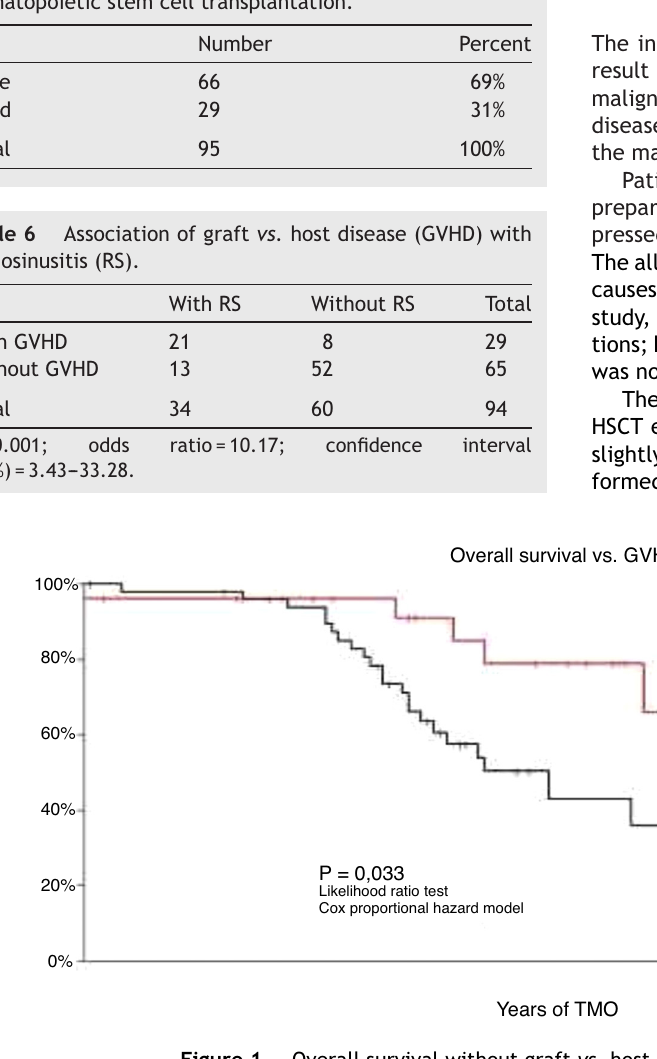
Overall survival without graft vs . host disease (GVHD) and with